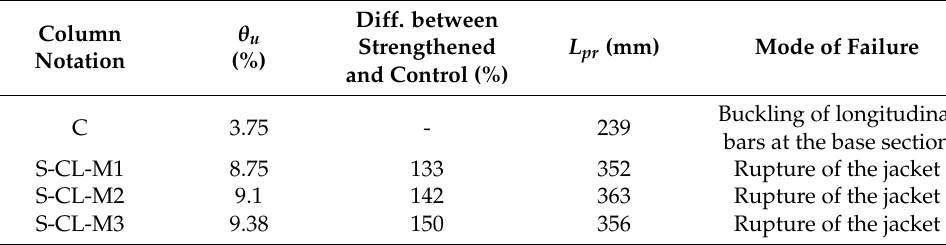
Table 5. Results of TRM Strengthened Column Models with Various Mortar